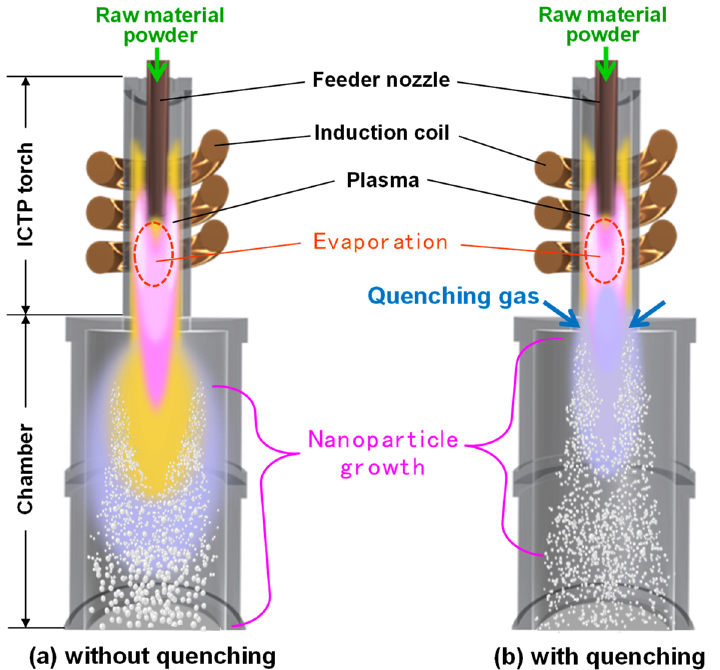
Figure 1. Schematic illustrations of nanoparticle fabrication in ICTP systems ( a ) without and ( b ) with quenching.